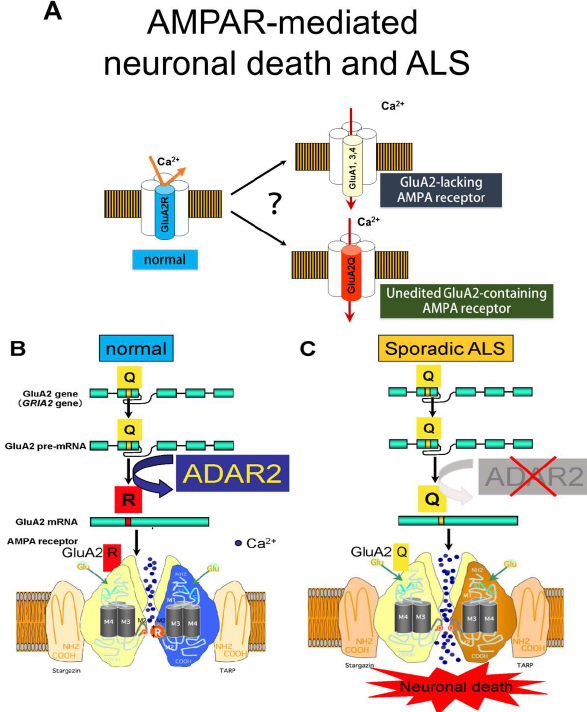
Figure 3. The α-amino-3-hydroxy-5-methyl-4-isoxazole propionic acid (AMPA) receptor and Ca 2+